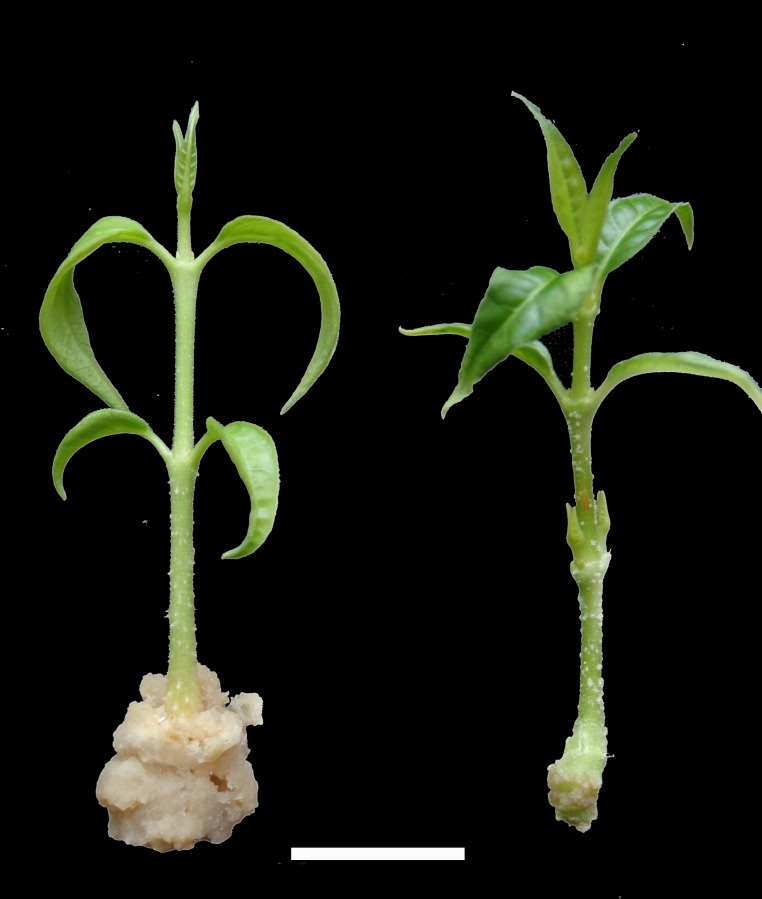
In vitro plants of W. tinctoria- Shoot inoculated in the absence of charcoal showing profuse basal callusing (left); against shoot inoculated in the presence of charcoal showing reduced/no basal callus mass (right).